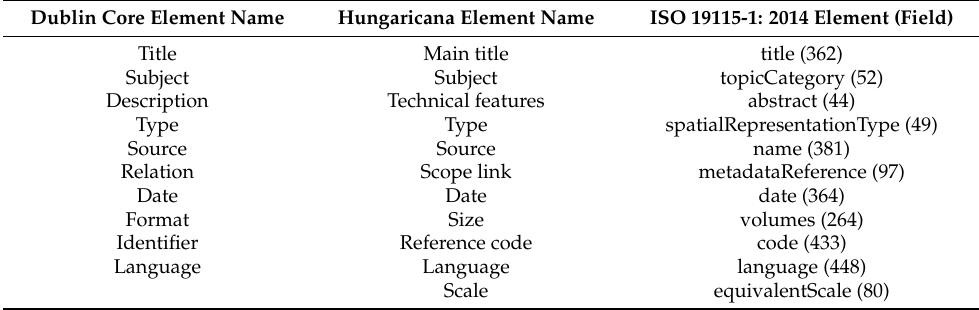
Table 4. Semantic mapping between Dublin Core and ISO 19115 elements.